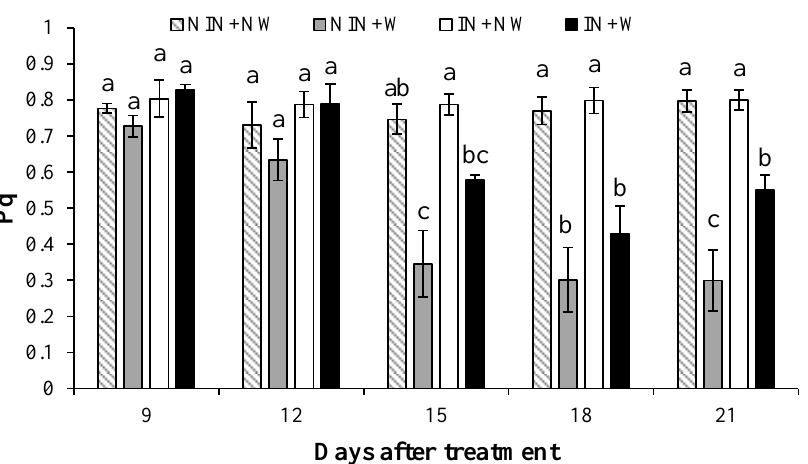
Figure 4. Pq in R. sativus under waterlogged conditions and inoculated with A. brasilense. Averages followed by different letters at each sampling point show statistical differences according to Tukey’s test ( p < 0.05). Vertical bars in each average indicate standard error ( n = 11).